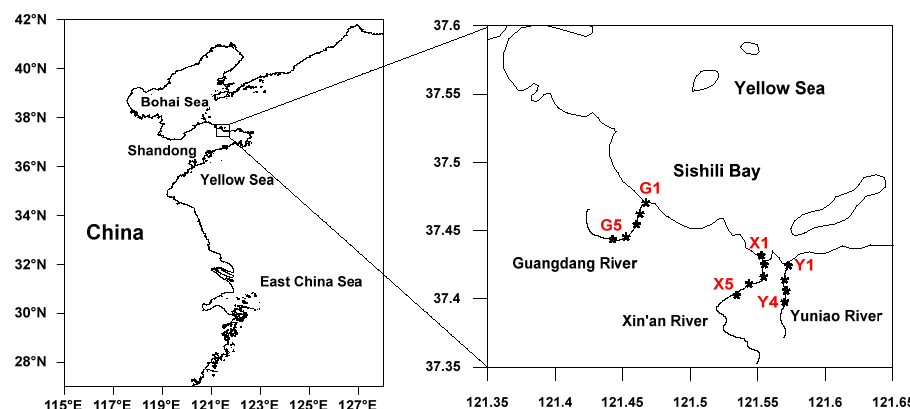
Figure 1. Sampling station locations of the main coastal rivers of Yantai Sishili Bay.